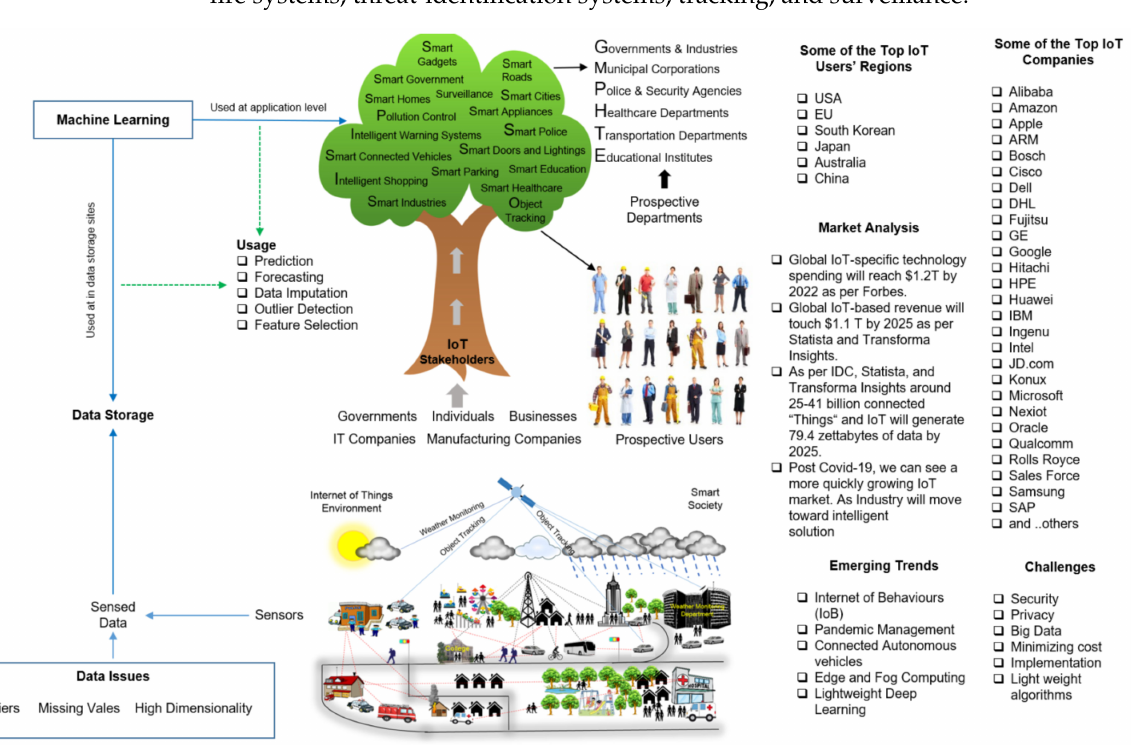
Figure 1. Infographic showing IoT landscape, stakeholders, and market